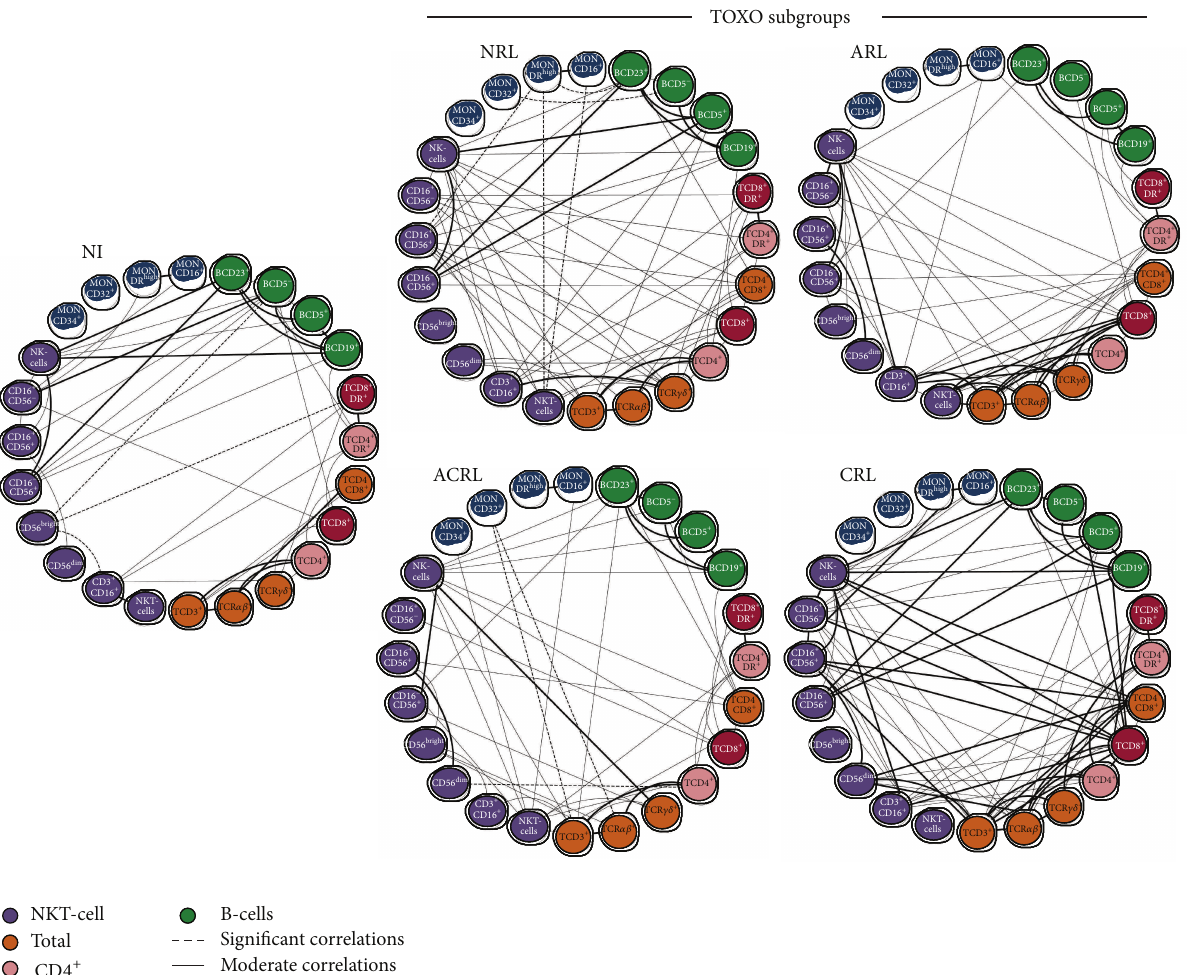
Figure 5: Biomarker networks of innate and adaptive immunity in the peripheral blood of infants with congenital toxoplasmosis categorized as no retinochoroidal lesions (NRL), active retinochoroidal lesions (ARL), active/cicatricial retinochoroidal lesions (ACRL), and cicatricial retinochoroidal lesions (CRL) compared to noninfected controls (NI). Networks were assembled to assess the association between leukocyte subpopulations, including monocytes, NK- and NKT-cells, T-cells (total, CD4 + , and CD8 + ), and B-cells. Significant correlations at 𝑃 < 0.05 are highlighted by connecting edges to underscore negative, moderate, and strong